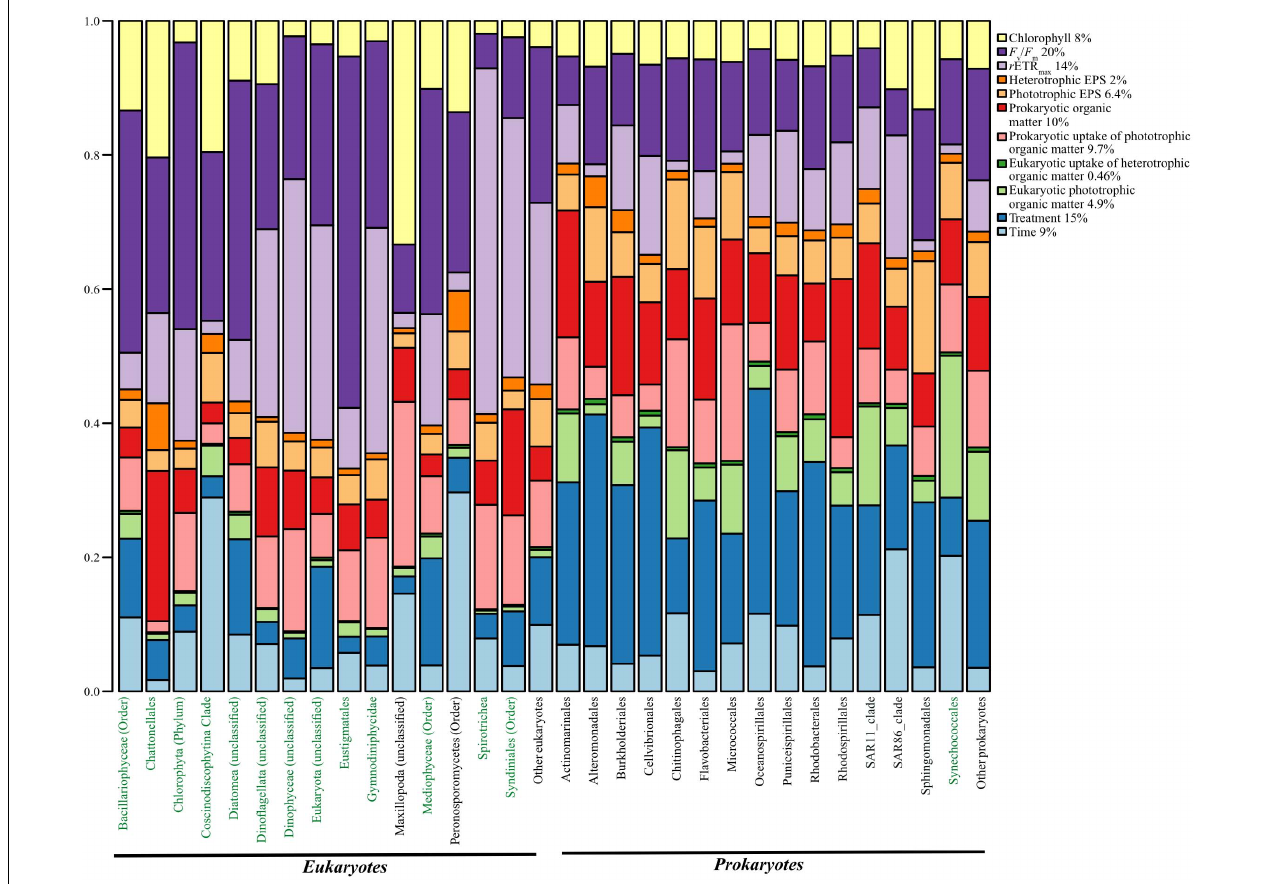
FIGURE 4 | Total proportion of variation in the occurrence of prokaryotic and eukaryotic species (phototrophs marked in green) explained by various environmental parameters tested in the long-term